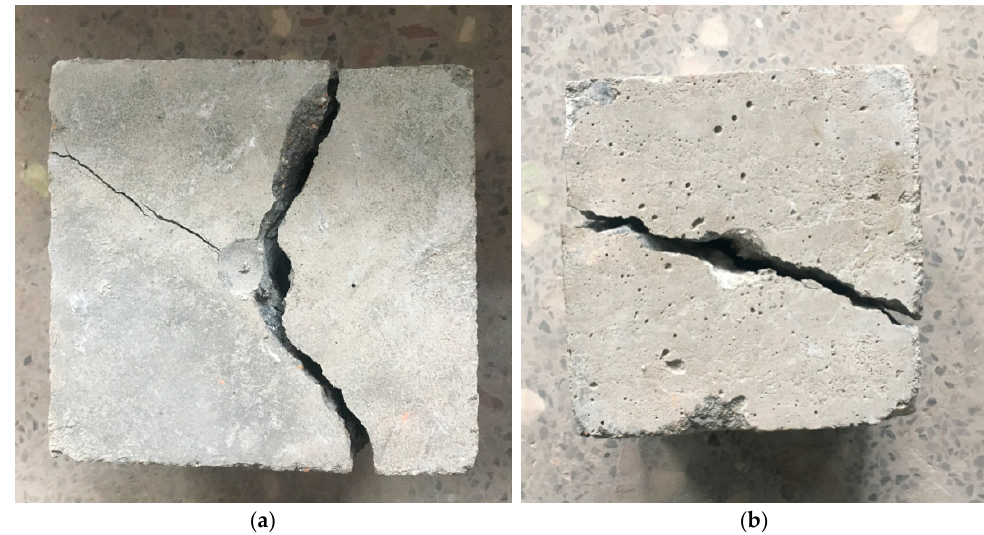
Figure 10. Impact damage diagram of concrete containing NS; ( a ) concrete without NS; ( b ) concrete mixed with 2% NS.